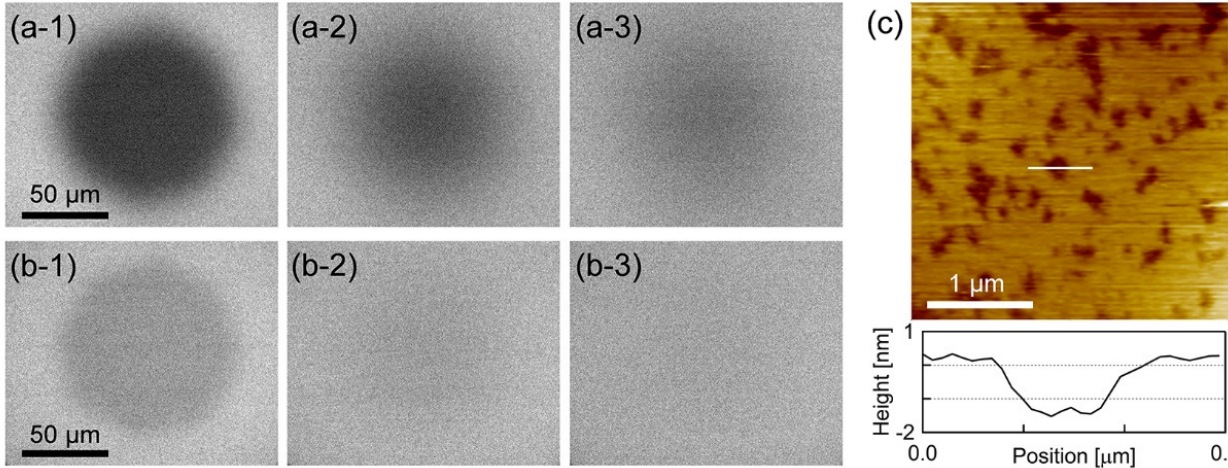
Figure 1. ( a , b ) Epi-fluorescence microscope images during FRAP of PI+PC-SLB including ( a ) BODIPY-HPC and ( b ) DiI-C18 obtained at (a-1, b-1) 0 s, (a-2, b-2) 10 min and (a-3, b-3) 20 min after photobleaching. ( c ) AFM topography of PI+PC-SLB and the cross-section profile at the white line.